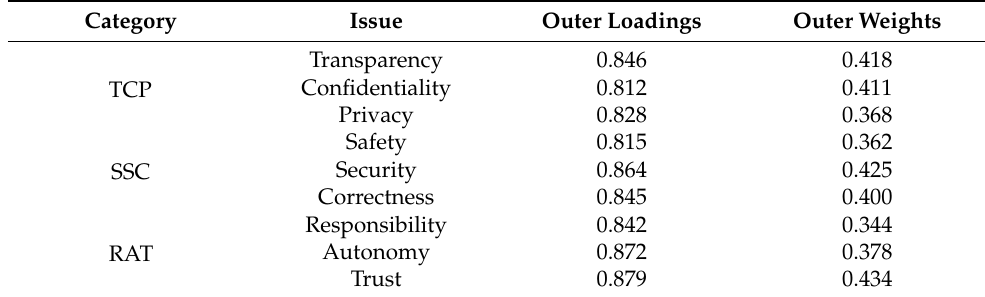
Table 3. Outer loadings and weights for ethical issues.